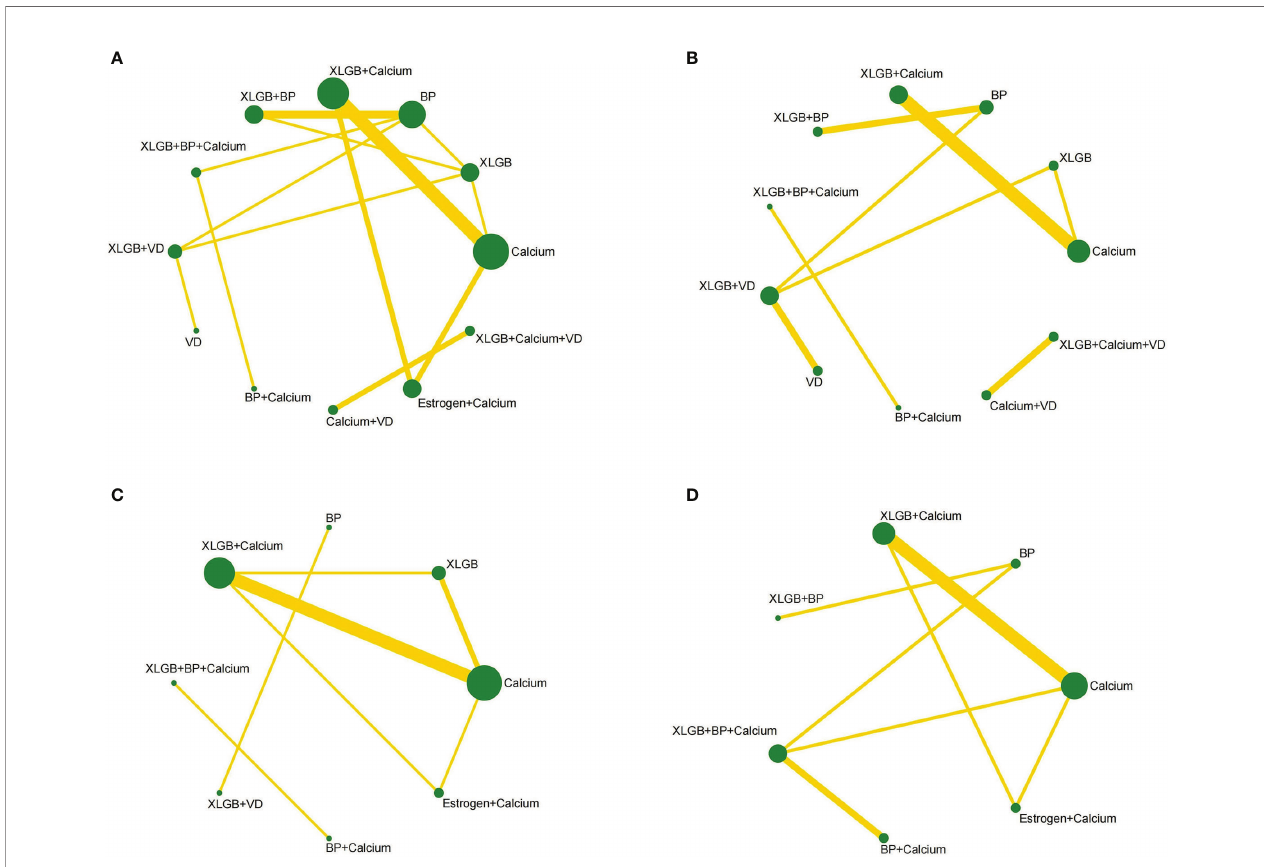
FIGURE 3 | Network diagrams depicting direct evidence used in network meta-analysis. (A) Network diagram of lumbar BMD. (B) Network diagram of BMD of femoral neck. (C) Network diagram of BGP. (D) Network diagram of